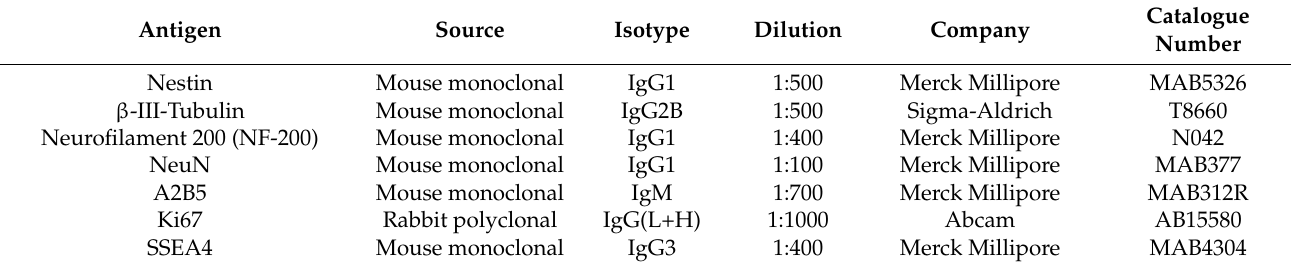
Table 2. List of primary antibodies used for